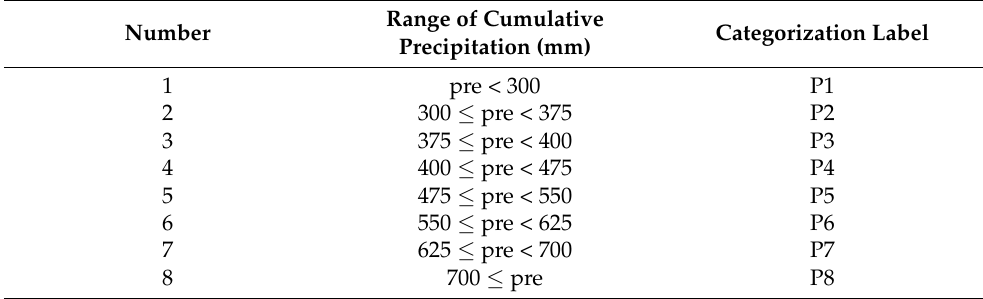
Table 5. Classification of cumulative precipitation